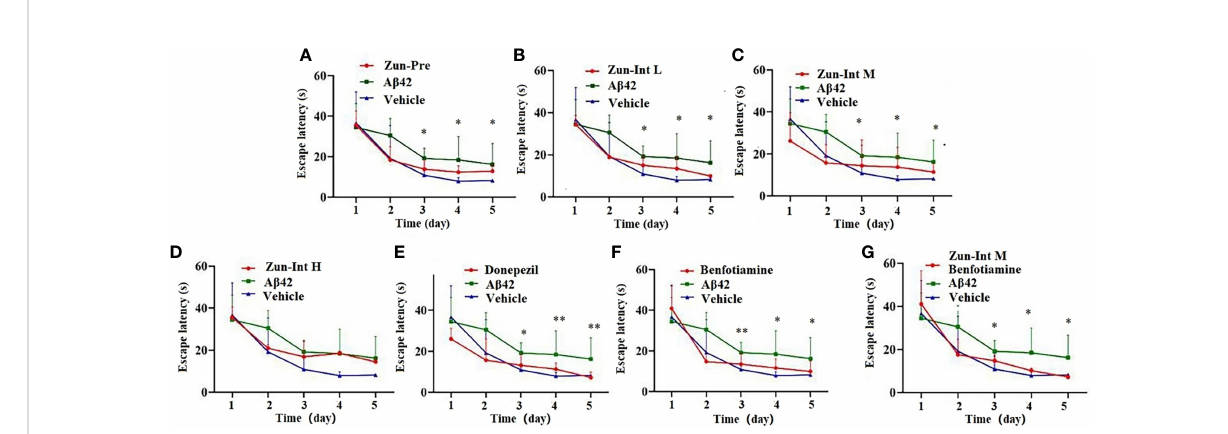
FIGURE 2 Effect of drug on the escape latency. (A) Zun-Pre: zunyimycin C preventive(14 mg/kg/d, intervene 21 days before modeling) effect, difference is signi fi c after three days. (B) Zun-Int L: low-dose zunyimycin C (7 mg/kg/d) interventive effect, difference is signi fi c after three days. (C) Zun-Int M: intermediate dose-dose zunyimycin C (14 mg/kg/d) interventive effect, difference is signi fi c after three days. (D) Zun-Int H: high- dose zunyimycin C (21 mg/kg/d) interventive effect, no difference is signi fi c after three days. (E) donepezil (5 mg/kg/d) interventive effect, difference is signi fi c after three days. (F) benfotiamine (5 mg/ kg/d) interventive effect, difference is signi fi c after three days. (G) benfotiamine (5 mg/kg/d) conjunction with intermediate-dose zunyimycin C (14 mg/kg/d) interventive effect, difference is signi fi c after three days. (n=7), *P < 0.05; **P <